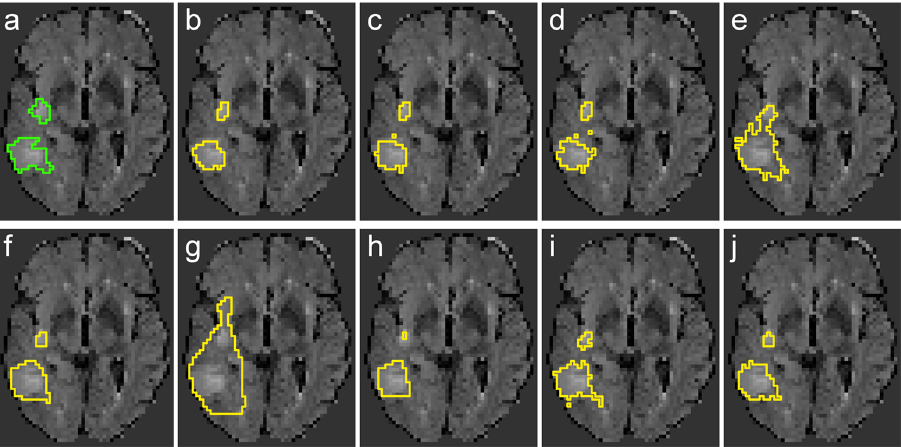
Fig 2. Results for case 21. Slice 21 with besteffort scenario trained on GTG. (a) ground-truth (GTG). (b) 100NN. (c) 10NN. (d) 5NN. (e) AdaBoost. (f) ET. (g) GNB. (h) GLM. (i) GB. (j) RDF.